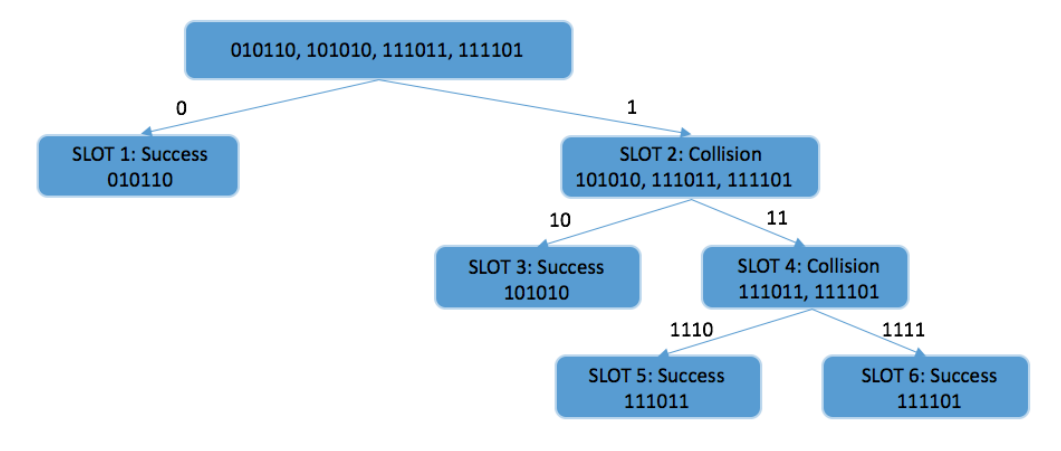
Figure 19. Example of the CT